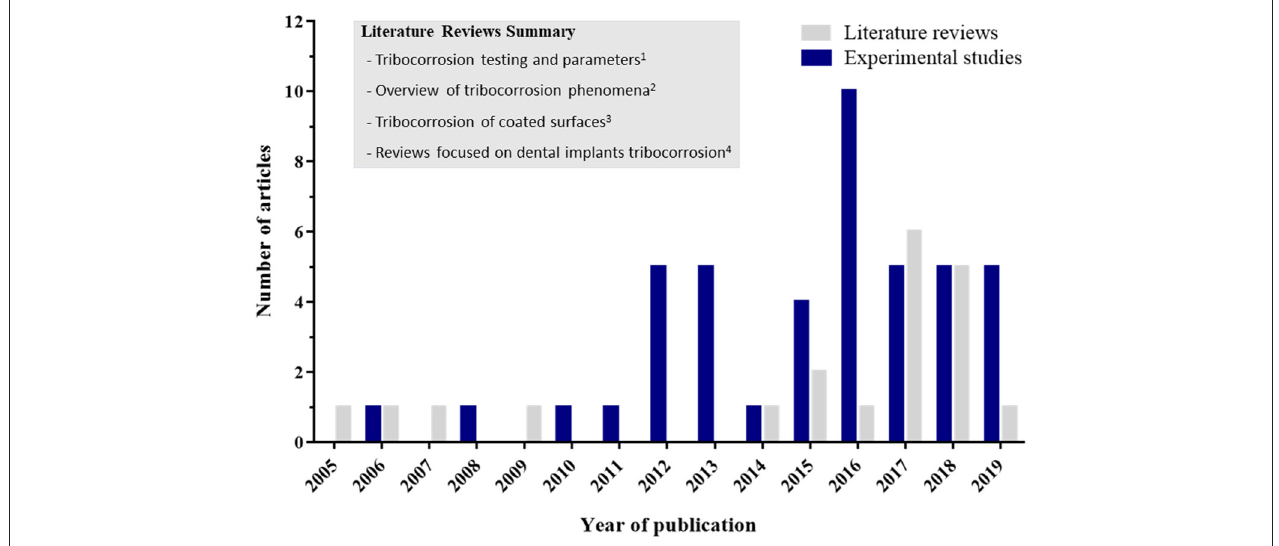
FIGURE 2 | Gray bars indicate the number of literature reviews published articles with significant discussion of tribocorrosion for restorative dentistry application. The literature reviews reference of each subtopic division are listed as follows: (1) ( Celis et al., 2006; Toh et al., 2018); (2) (Mathew et al., 2014a; Dundon et al., 2017; Espallargas et al., 2017; Villanueva et al., 2017; Cao and Mischler, 2018; López-Ortega et al., 2018; Mombelli et al., 2018; (3) Stack, 2005; Wood, 2007; Wang et al., 2015; Manoj et al., 2019 ; and, (4) Mathew et al., 2009; Souza et al., 2015; Apaza-Bedoya et al., 2017; Balla and Das, 2017; Revathi et al., 2017; Delgado-Ruiz and Romanos, 2018; Noronha Oliveira et al., 2018 ). Blue bars indicate the number of tribocorrosion published articles of dental implants and frameworks materials in experimental